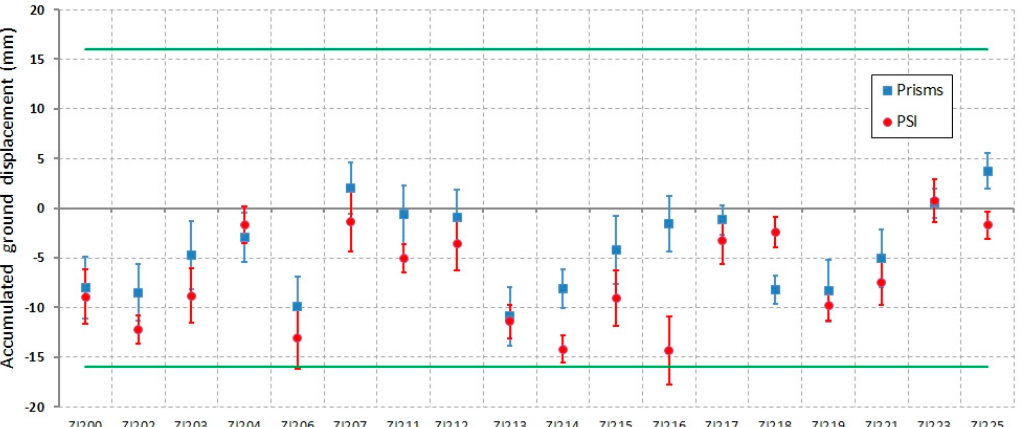
Figure 14. Accumulated displacements from 11 November 2015 to 15 May 2017 for prisms (robotic station) and corresponding PS (closed to the prisms positions) and its related standard deviations in the Sela & Tulipa dike. The error bar limits (±16 mm) are shown in green. Several points in the Sela & Tulipa dike (ZI200, ZI202, ZI206, ZI2013, ZI214, ZI215, ZI216,